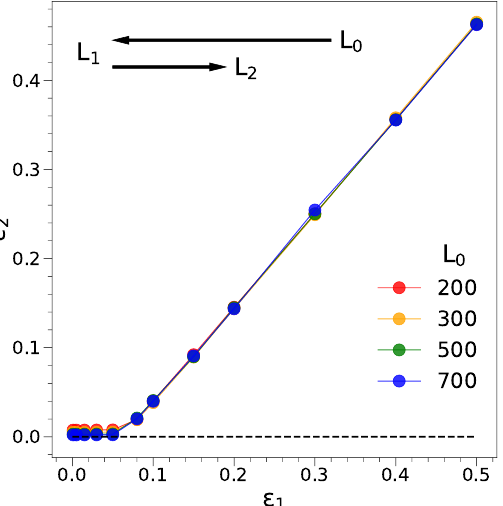
Figure 1. Mechanical response of the film under a compression/decompression cycle. The film with initial length L 0 is uniaxially compressed up to L = L 1 with strain ε = ε 1 and later decompressed. The decompression leaves the film with residual deformation L = L 2 and strain ε = ε 2 . Elastic response, corresponding to ε 2 = 0, i.e., L 2 = L 0 , is observed up to about ε 1 (cid:39) 0.05. Plastic effects are apparent at larger compressions and virtually independent of the film length. The film lengths are in units of the reference length σ , the approximate monomer diameter. In the case of polyethylene (polystyrene), one deduces a reference length σ = 5.3 ( 9.7 ) Å; see Section